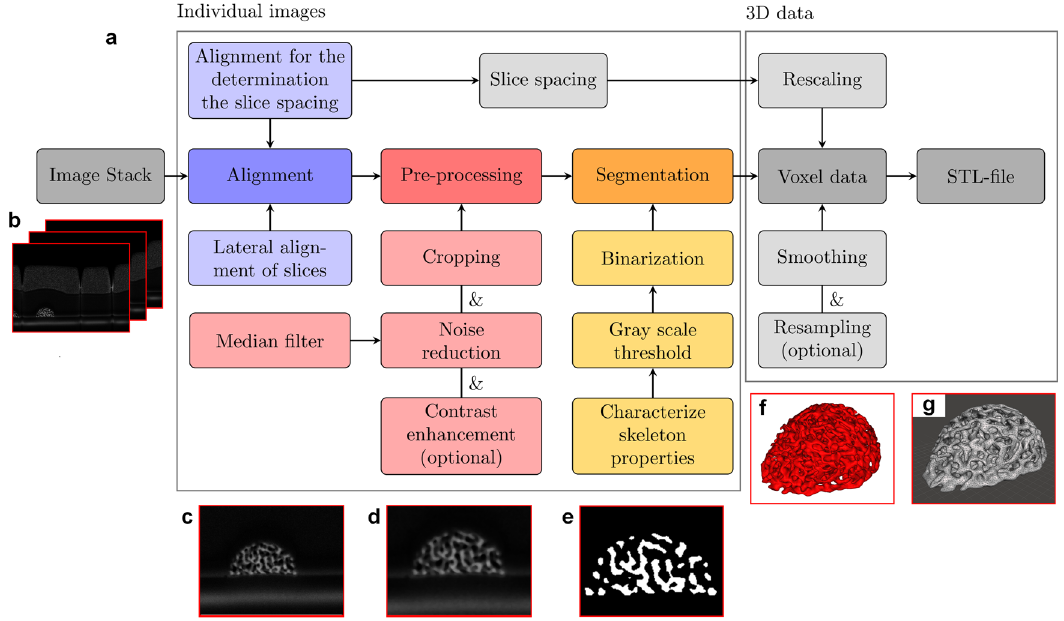
Fig. 2 Schematic representation of the reconstruction process. a Schematic work fl ow for the reconstruction of the 3D models of gold nanosponges from an SEM image stack, generalized for both cases, the fi ne- and the coarse-pored particle. b – e Exemplary images from the same FIB section, as displayed in Fig. 1e and f, of the fi ne-pored sponge at different stages of the reconstruction process: b the raw stack, c after alignment and cropping, d after median fi ltering, e the binarized and cropped image, f the 3D voxel model and g the fi nal smoothed meshed 3D model. COMMUNICATIONS MATERIALS| (2023) 4:20